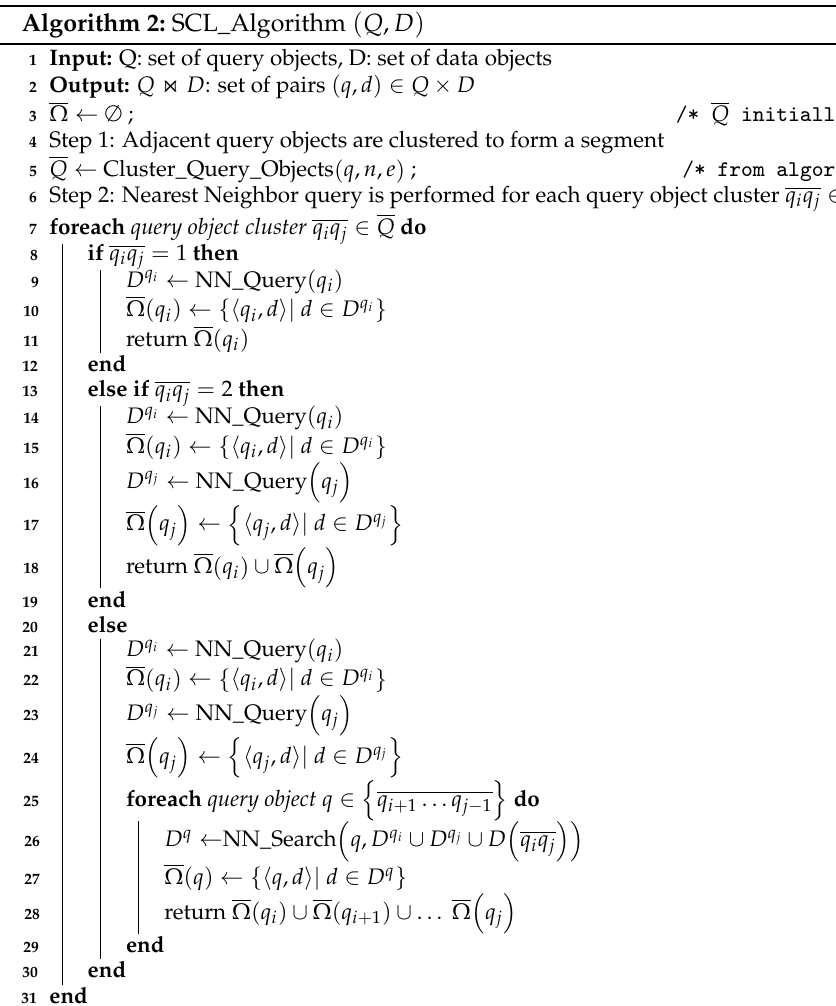
Algorithm 2: SCL_Algorithm ( Q , D